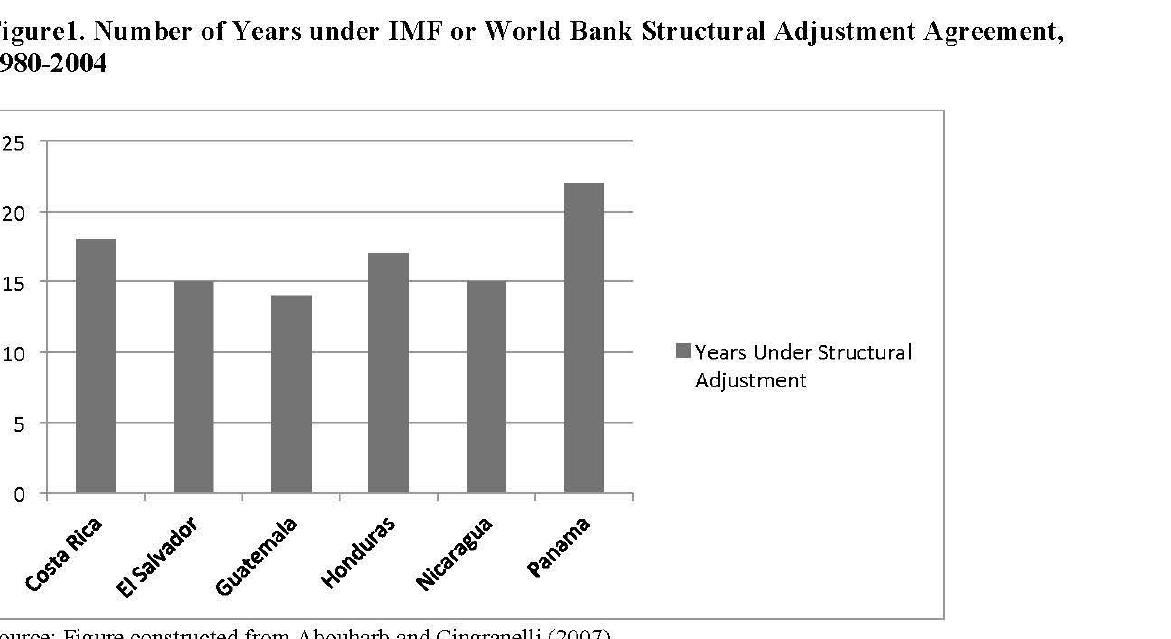
• Years Under Structural